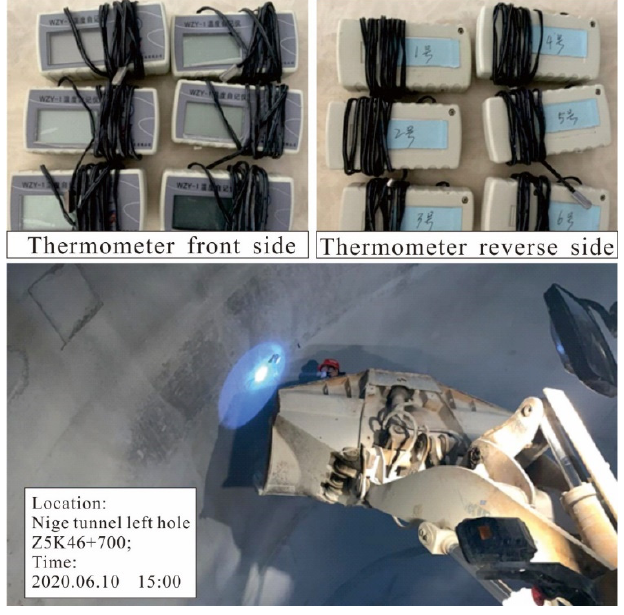
Figure 3. Thermometer and its field